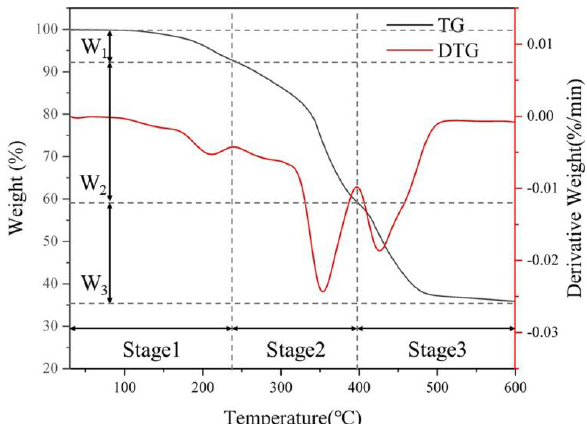
Figure 4. Thermogravimetry (TG) and Derivative thermogravimetry (DTG) analysis of